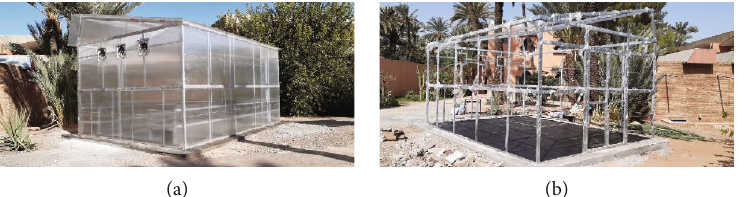
Figure 1: Photograph of modi fi ed greenhouse dryer structure (a) without and (b) with polycarbonate sheet.